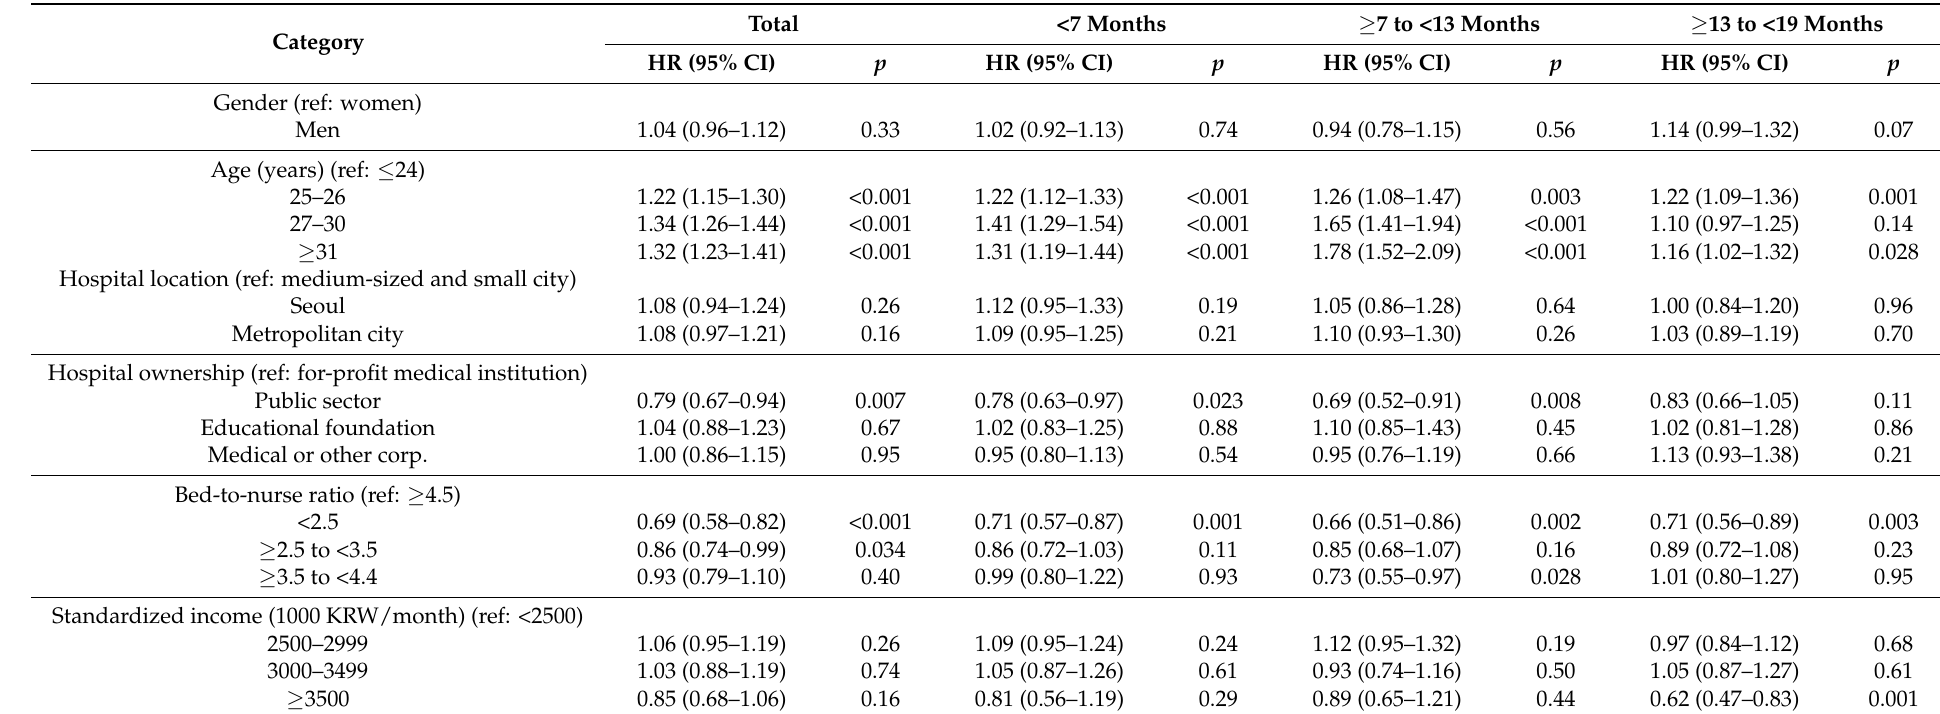
Table 4. Characteristics of hospitals and nurses as risk factors of turnover among newly hired nurses ( n =